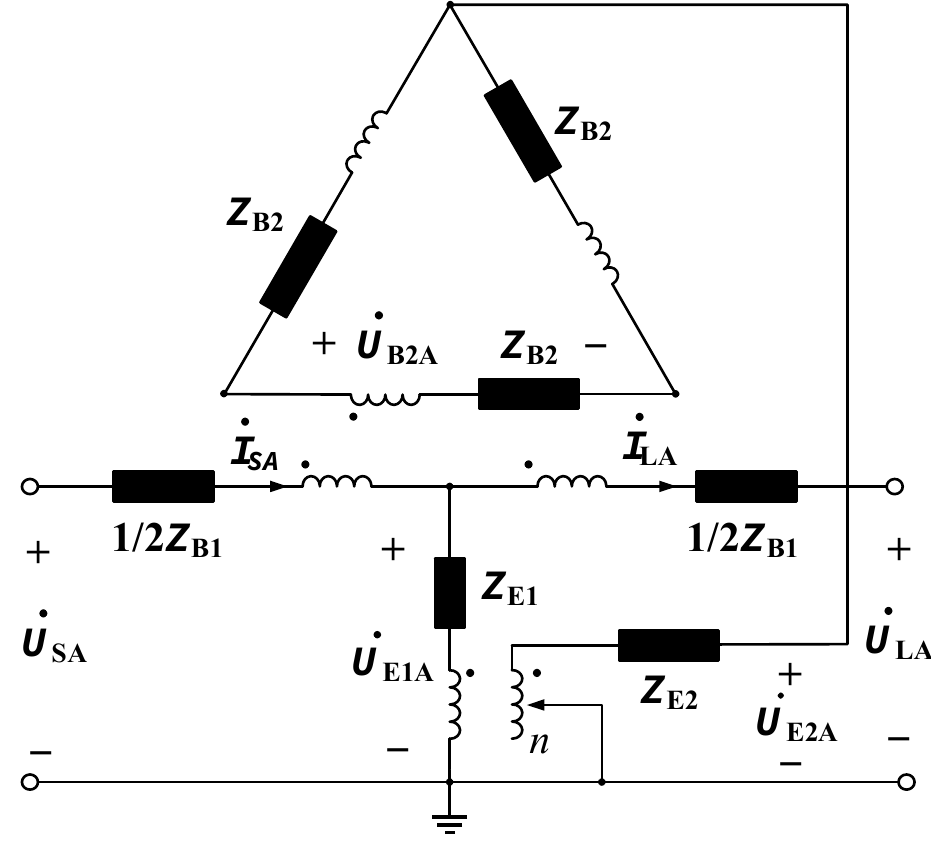
Figure 6. Equivalent circuit of two core symmetrical PST .